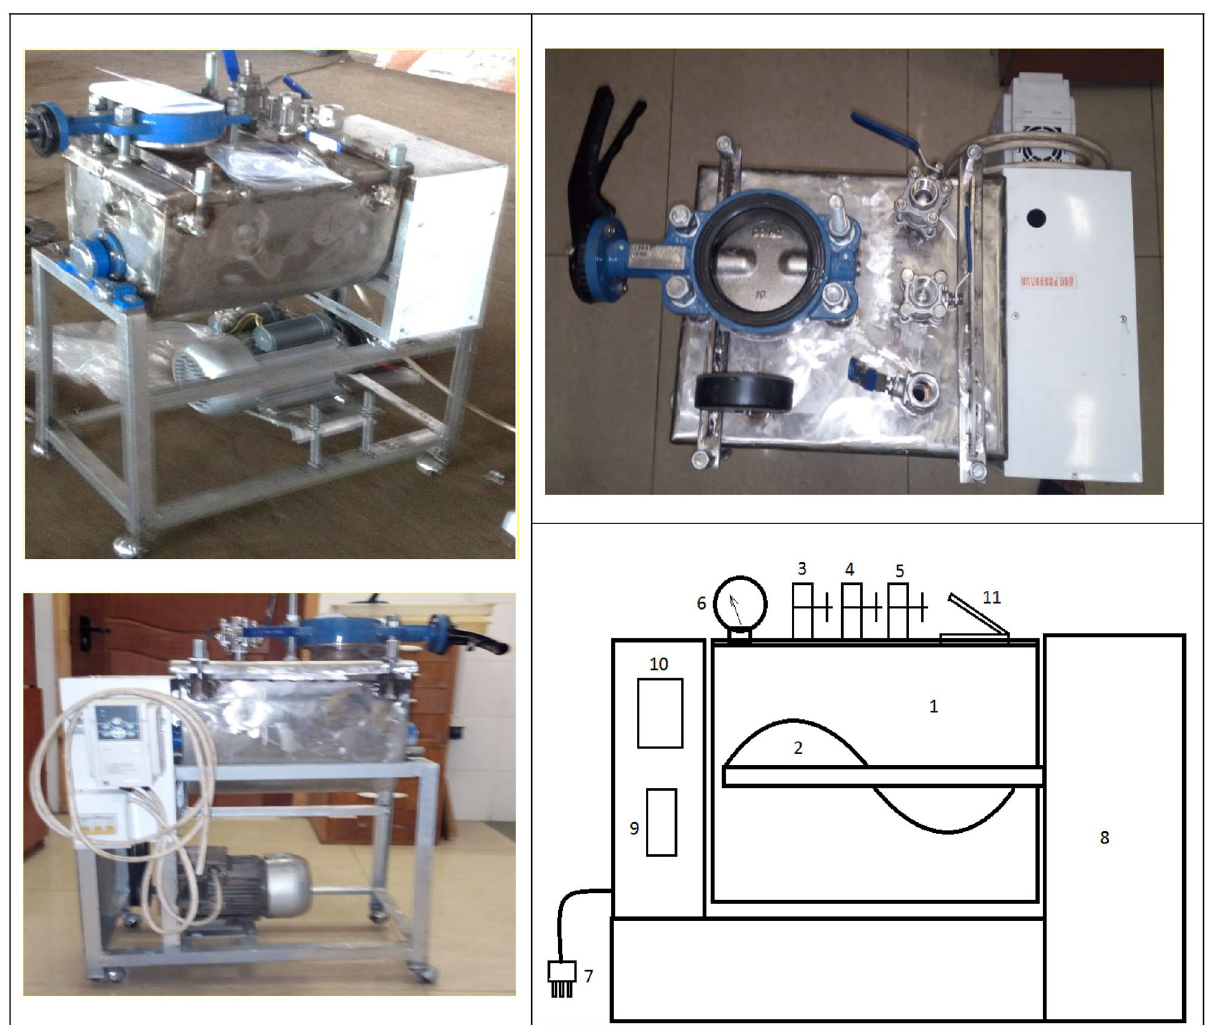
Figure 5. Ion-ozone cavitation unit for dough preparation with an accelerated cycle: 1—container for dough preparation; 2—bubble shaft; 3—flour dispenser; 4—dispenser for water and other components; 5—branch pipe for supplying ozone, or molecular or atomic ions of oxygen in the air; 6—pressure detection sensor; 7—electric wire; 8—electric drive; 9—fuses; 10—electrical converter; 11—cavitator lever.